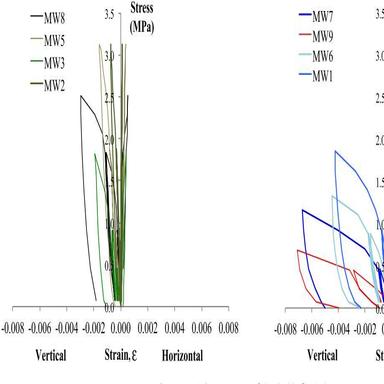
Strain/stress curves of the double flat-jacks tests.